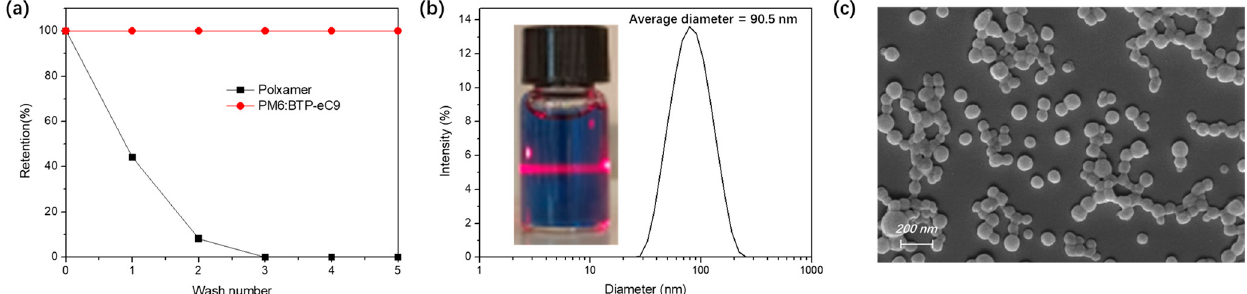
Figure 2. ( a ) Poloxamer retention as a function of centrifugal washes at 4 °C in aqueous PM6:BTP − eC9 ssNP ink; ( b ) size distribution of PM6:BTP − eC9 ssNP ink and its tyndall effect;